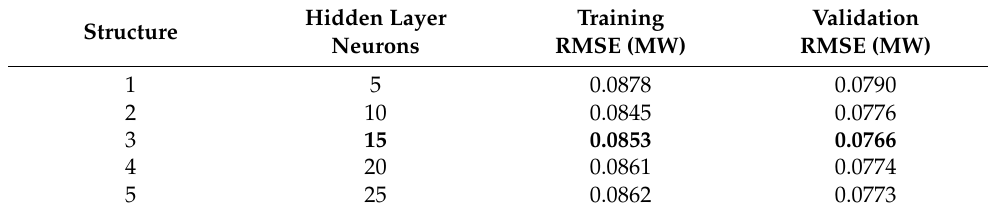
Table 2. FFNNs structures’ averaged results for fixing hidden layer’s number of neurons.